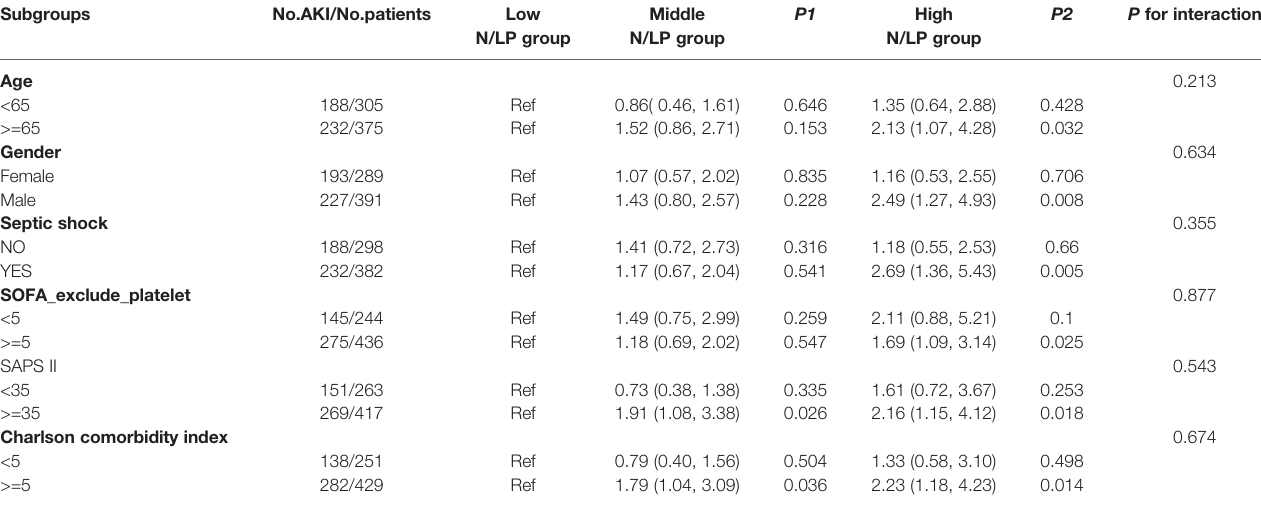
TABLE 4 | Subgroup analysis regarding the in fl uence of different N/LP level in the severe AKI occurrence. Subgroups